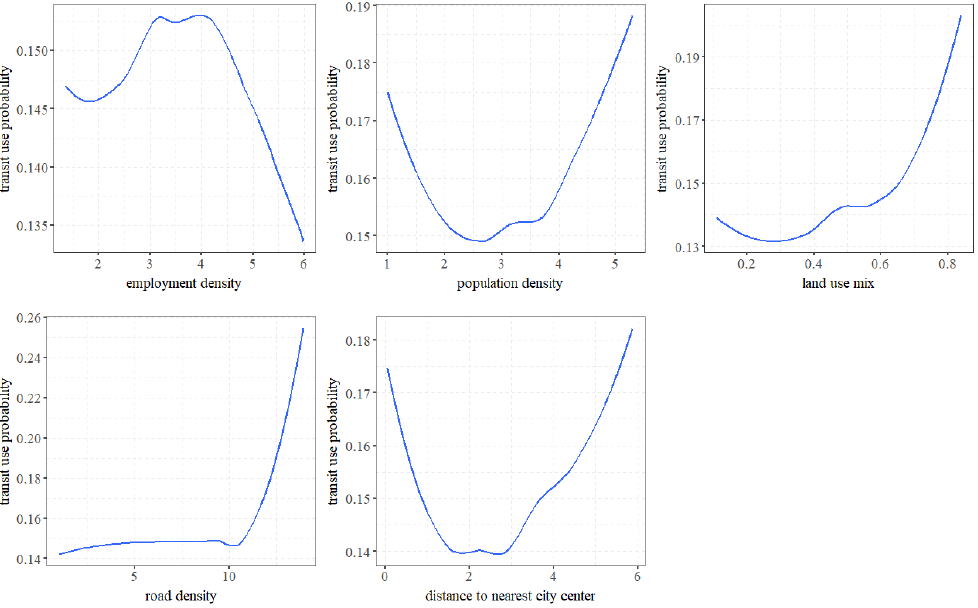
Figure A1. Nonlinear effects of other built environment features on transit use in the central city.